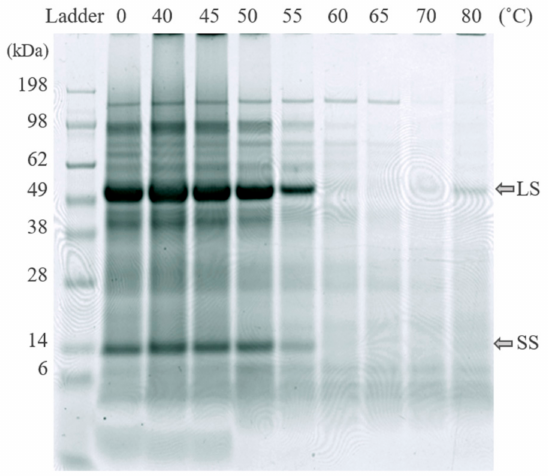
Figure 6. Effects of thermal treatment temperature on protein composition (analyzed using SDS- PAGE) in particle-free supernatant (fraction S1) from sugarbeet biomass. LS: large subunit, SS: small subunit of